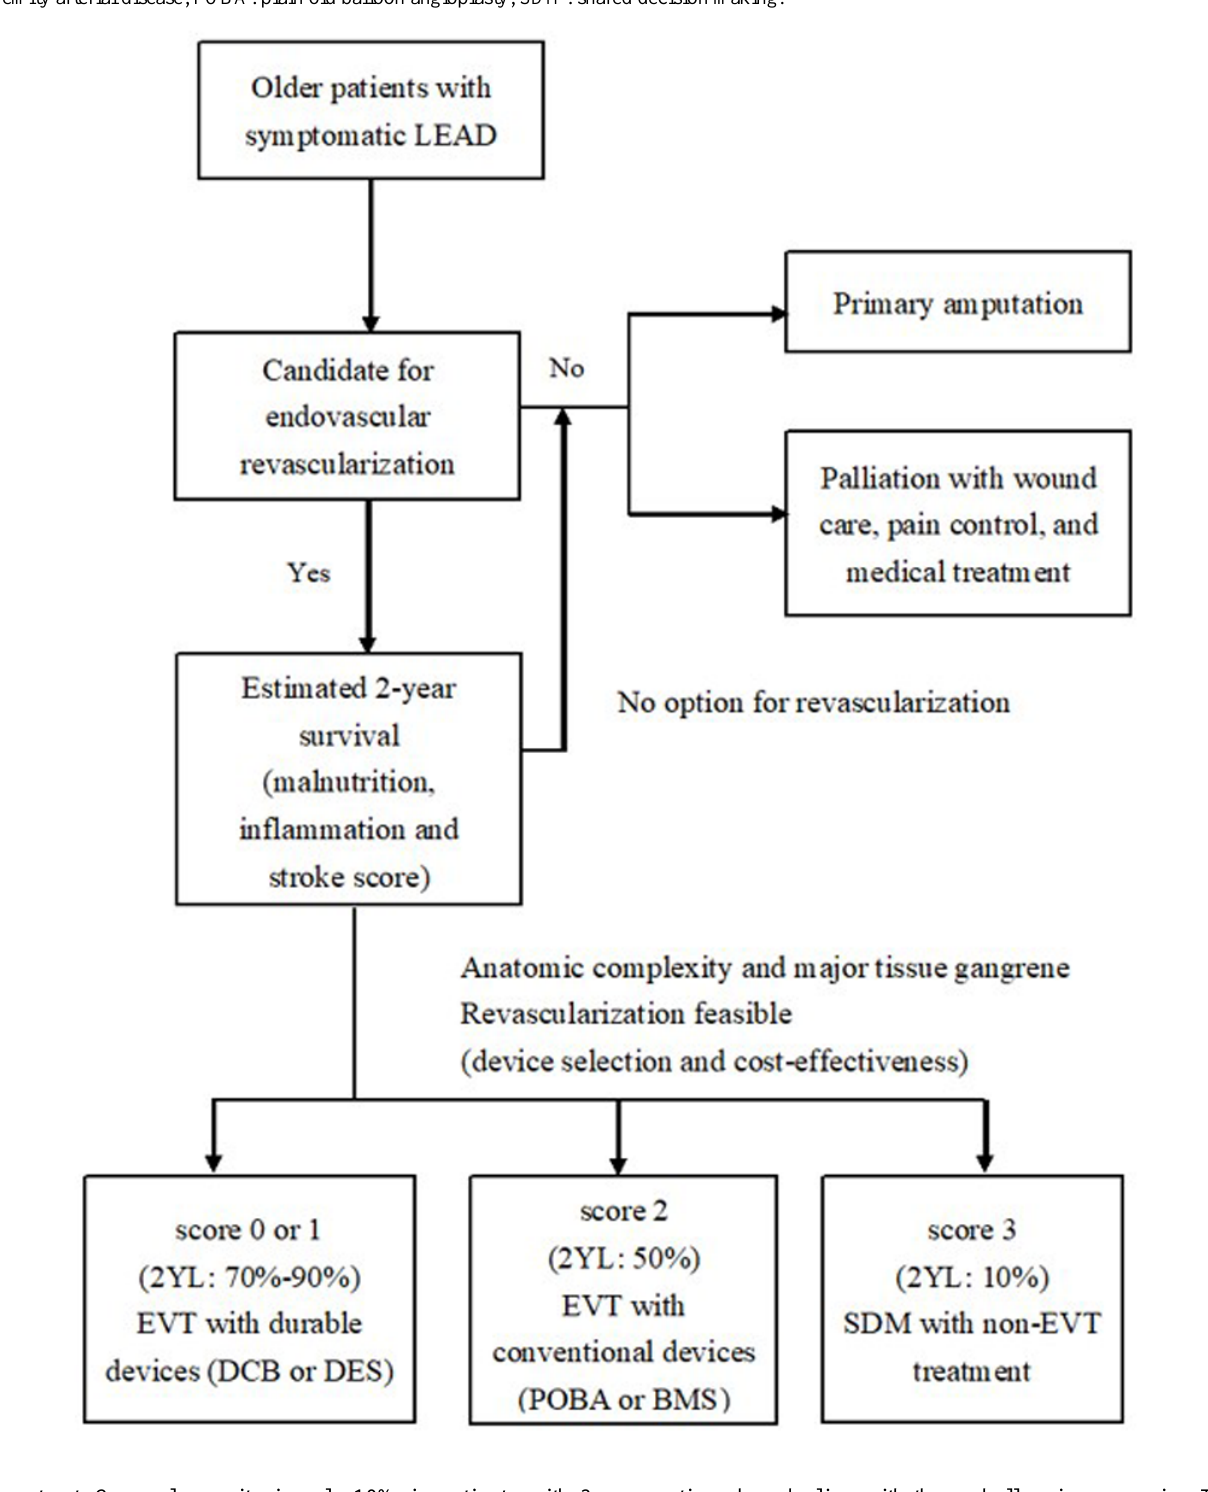
Figure 7. Treatment framework using the malnutrition, inflammation, and stroke score for older patients with symptomatic lower extremity arterial disease. 2YL: 2-year longevity; BMS: bare-metal stent; DCB: drug-coated balloon; DES: drug-eluting stent; EVT: endovascular therapy; LEAD: